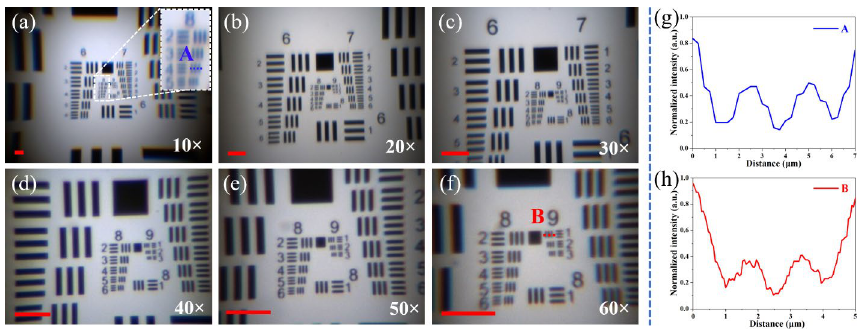
Fig. 8 Captured images of the resolution target. (a) Magnification 10 × . (b) Magnification 20 × . (c) Magnification 30 × . (d) Magnification 40 × . (e) Magnification 50 × . (f) Magnification 60 × . The scale bars in these pictures are 20 μm. (g) The normalized intensity distribution of the fourth element of the Group-8 at 10 × . (h) The normalized intensity distribution of the first element of the Group-9 at 60